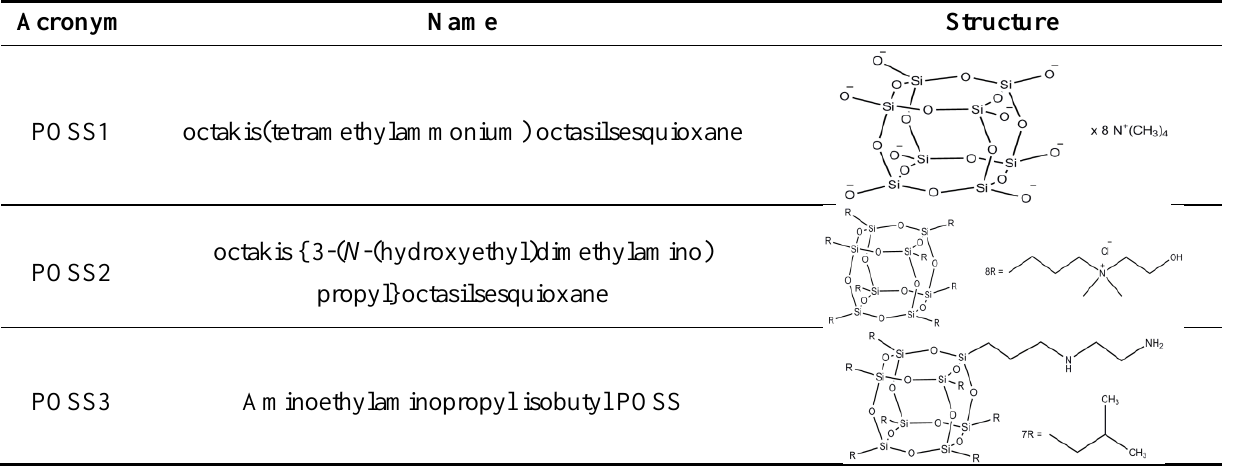
Table 1. Polyhedral oligomeric silsesquioxanes (POSS) used for modification of bentonite and hydrated